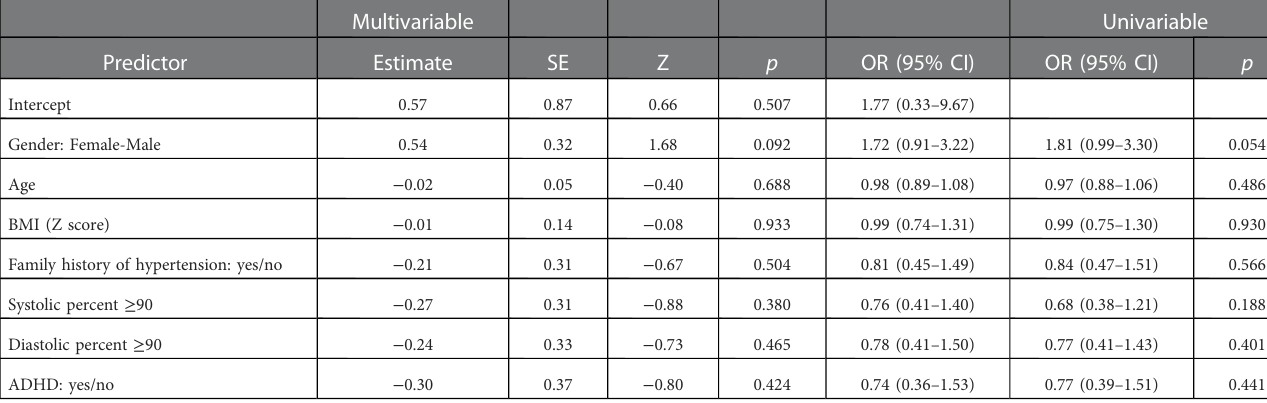
TABLE 3 Model coef fi cients for logistic regression analysis predicting hypertension.